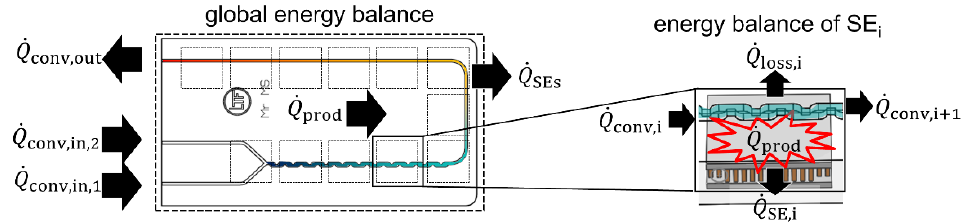
Figure 2. Shift from global to local energy balance of the system.